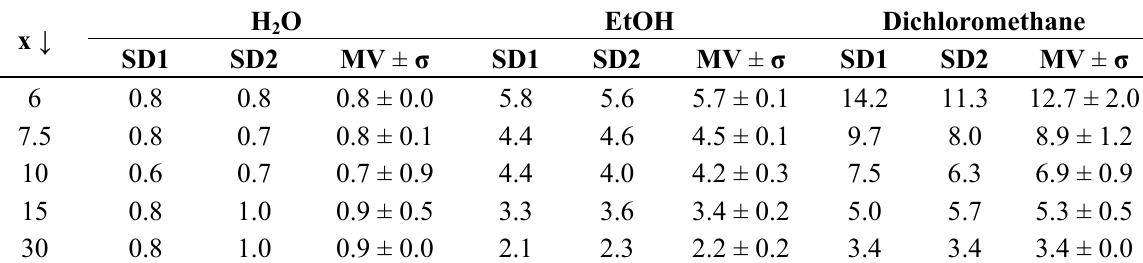
Table 2. The swelling degrees of p EtOx and dichloromethane. The swelling degrees according to ( m determined in duplicate [SD1 and SD2, respectively; the average is represented by the arithmetic mean value (MV) and the standard deviation, σ ].